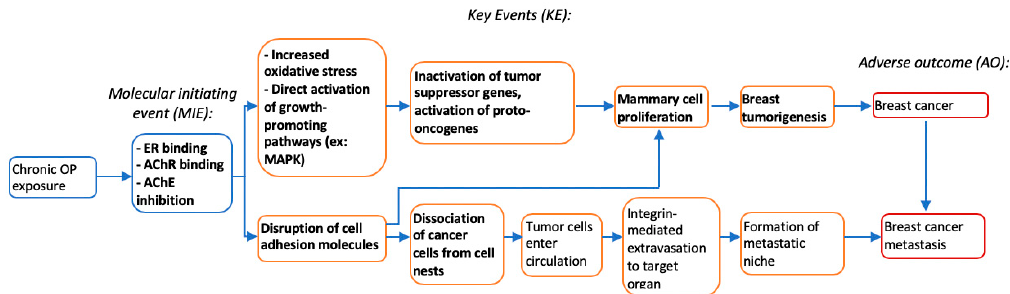
Figure 2. Adverse outcomes pathway including proposed mechanisms of chronic OP exposure